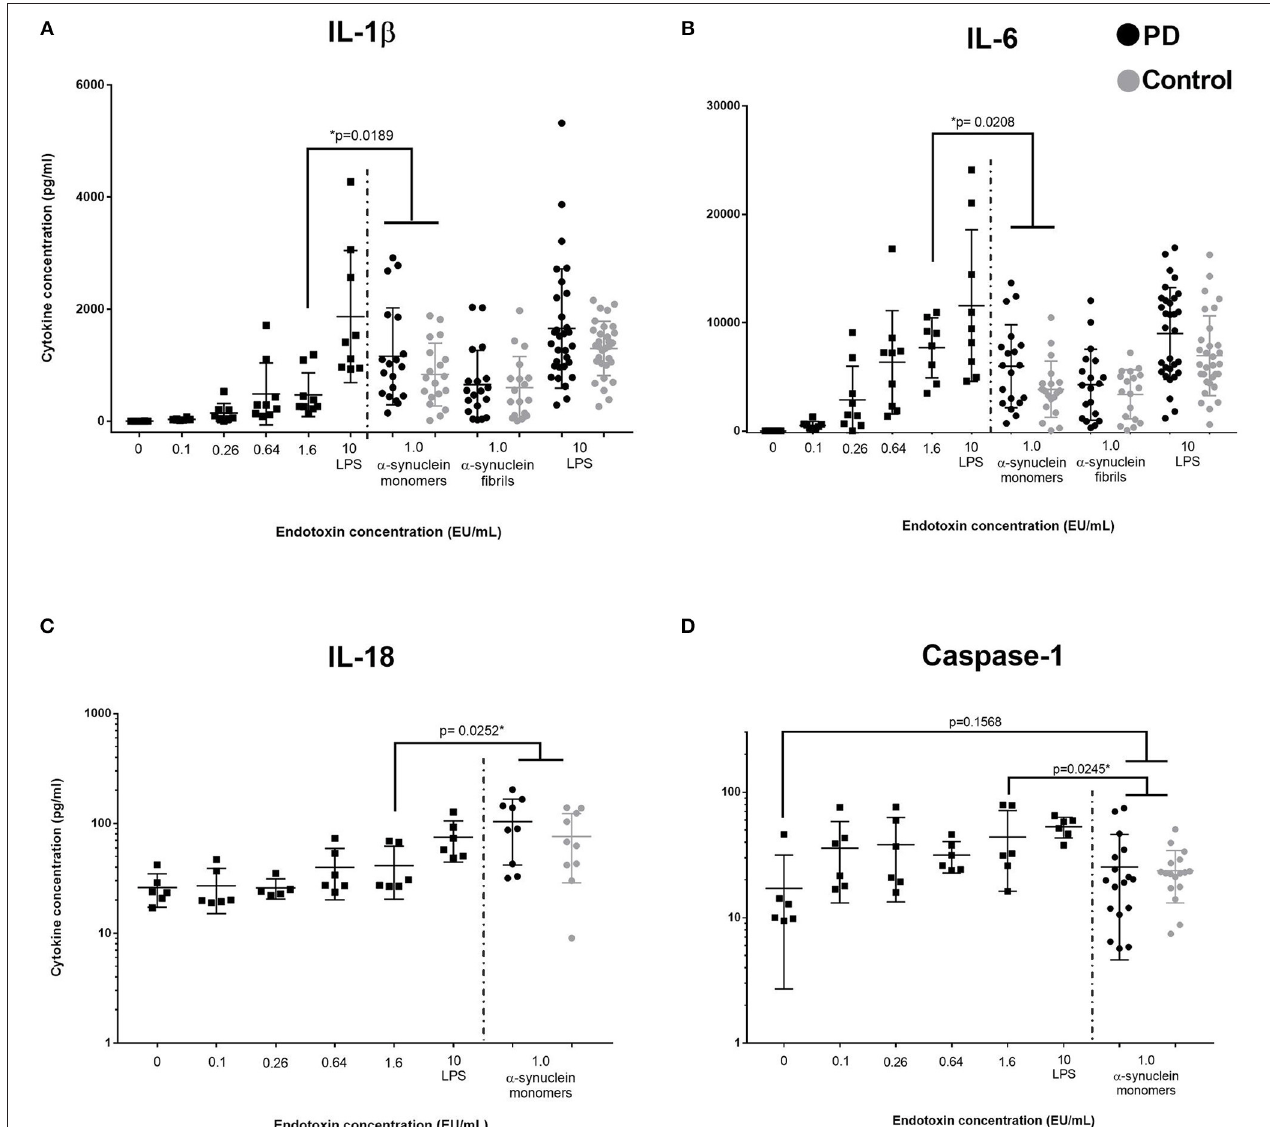
FIGURE 2 | Comparison of low concentration endotoxin and α -synuclein stimulation of PBMCs. Squares represent cytokine concentrations from PBMC cultures with varying concentrations of endotoxin ( A, B : n = 9, 5 PD and 4 controls, C,D : n = 6, 3PD and 3 controls, assayed in duplicate; left of dashed line). Circles represents PD (black) and control (gray) concentrations in post-culture supernatants from the original assays cultured with α -synuclein monomers, fibrils, or LPS ( α -synuclein conc: 1 nmol = 27.3ng/ml, LPS conc: 1ng/ml). P -values indicates comparison between 1.6 EU/ml (comparable to endoxin level in our α -synuclein preparation) and grouped PD/control cohort stimulated by α -synuclein monomers (No PD/control differences were observed in post-culture cytokine concentrations) Bars represent mean value and first and third quartiles. (A) Data suggest that IL-1 β production is stimulated by α -synuclein in excess of stimulation by the equivalent value of endotoxin present as a contamiant. (B) IL-6 (and all other measured cytokines) do not show this increased production. Data indicates that endotoxin is the primary driver of elevated IL-6 concentration, rather tha α -synuclein. (C) IL-18 prodution is also significantly increased in response to α -synuclein stimulation, compared to stimulation with an endotoxin concentration comparable to contaminating levels. (D) Caspase-1 levels are not significantly increased by α -synuclein stimulation compared to the unstimulated